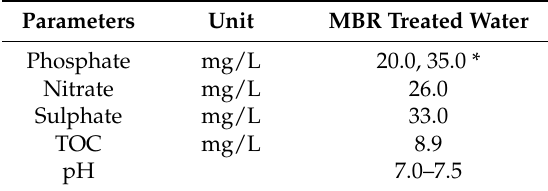
Table 1. Characteristics of MBR treated